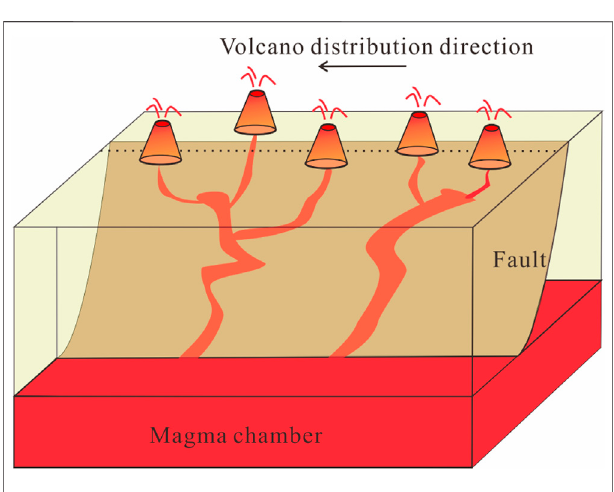
FIGURE 7 | Beaded distribution of intermediate-acid volcanic edi fi ces along faults.